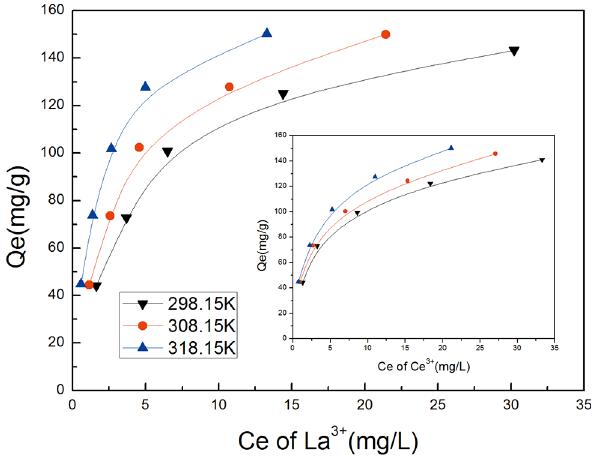
Fig 6. Adsorption isotherms of La 3+ and Ce 3+ on SA-PGA gel particles.